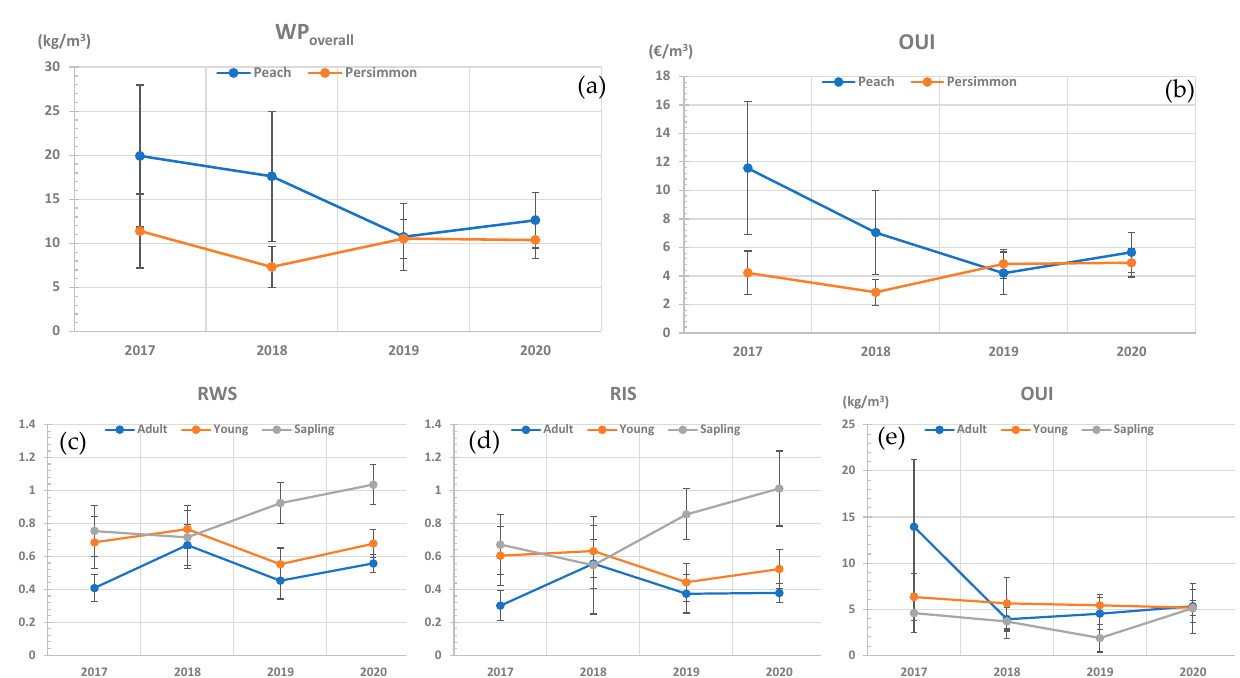
Figure 3. Interactions of year × crop and year × size. The graphs ( a , b ) show the variation in WP overall and OUI averages, respectively, in the years studied. The graphs ( c – e ) show the variation in RWS, RIS, and OUI averages, respectively, in the years studied. Error bars represent the 95% confidence interval of each value.